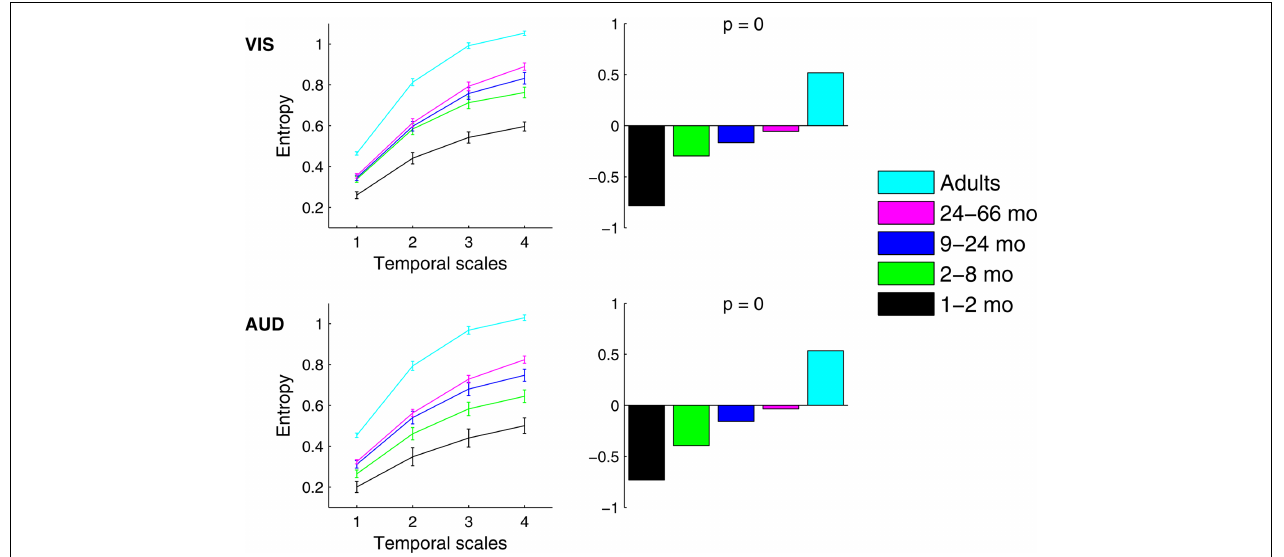
FIGURE 2 | Age-related differences in multiscale entropy estimated separately in VIS and AUD conditions. Left panels show group mean entropy with error bars representing group standard errors. Right panels show PLS contrasts representing age-related increase in entropy. Contrasts for both conditions were signifi cant and stably expressed across all temporal scales.